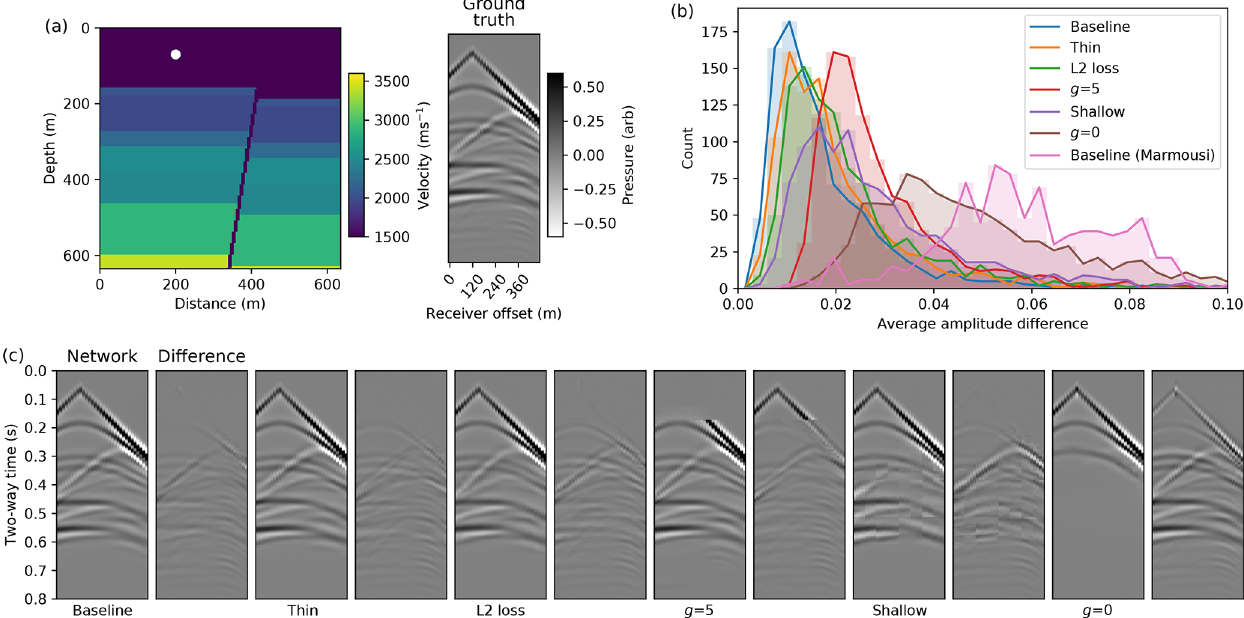
Figure A2. Comparison of different conditional autoencoder network designs and training hyperparameters on simulation accuracy. (a) A randomly selected velocity model and source location from the test set and its corresponding ground truth FD simulation. (b) The histogram of the average absolute amplitude difference between the ground truth FD simulation and the simulation from the different cases over the test set. The histogram of the baseline network over the Marmousi test dataset is also shown. (c) A comparison of simulations and their difference to the ground truth when using our proposed conditional autoencoder (baseline), when halving the number of hidden channels for all layers (thin), when using an L2 loss function during training (L2 loss), when using gain exponents of g = 0 and g = 5 in the loss function and when removing two layers from the encoder and eight layers from the decoder (shallow). A t 2 . 5 gain is applied for display.